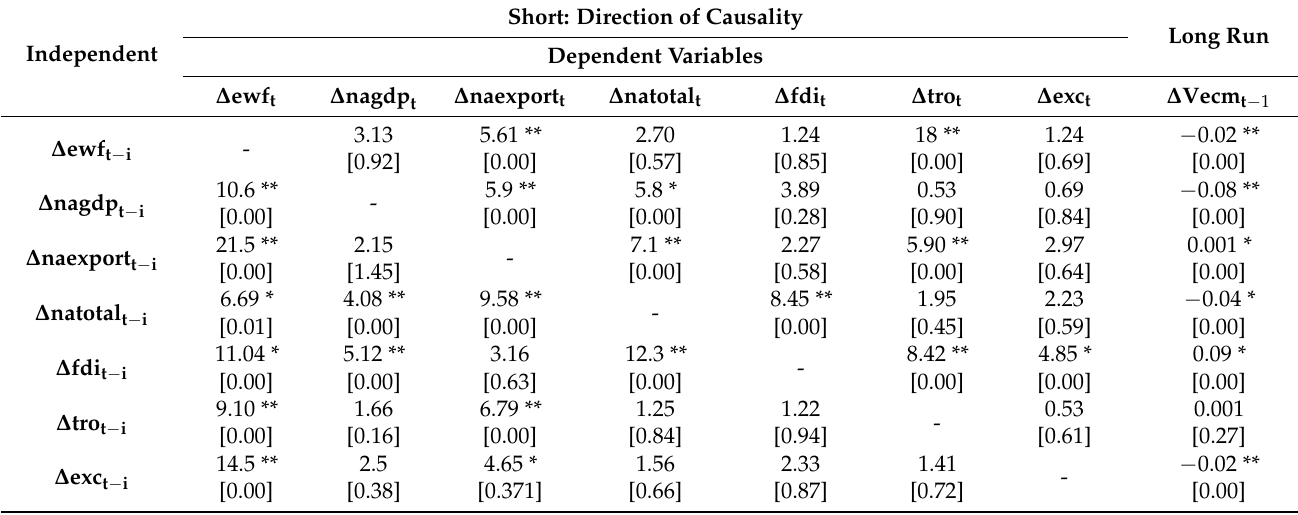
Table 5. Summary results of the granger causality tests.